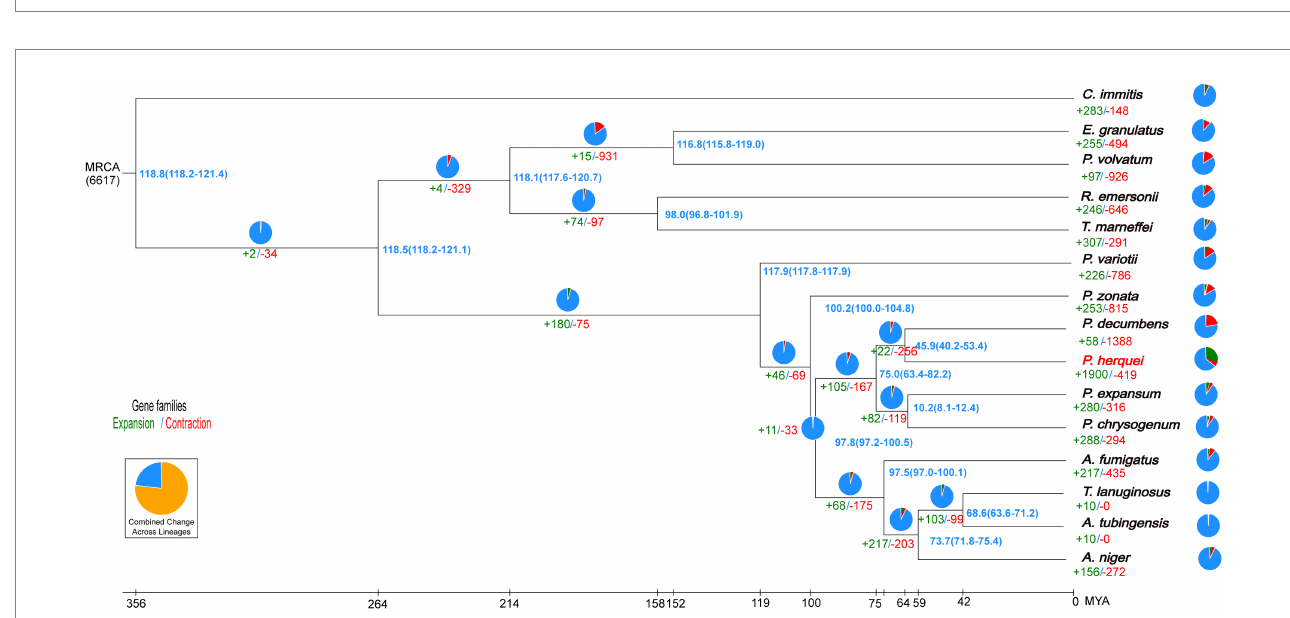
FIGURE 2 Phylogenetic tree of Penicillium herquei and sequences of the 14 fungal species available from GenBank. The blue numbers on the nodes are divergence times in units of million years ago. Numbers for significantly expanded (+, green) and contracted ( − , red) gene families are shown below branches or taxon names with percentages indicated by pie